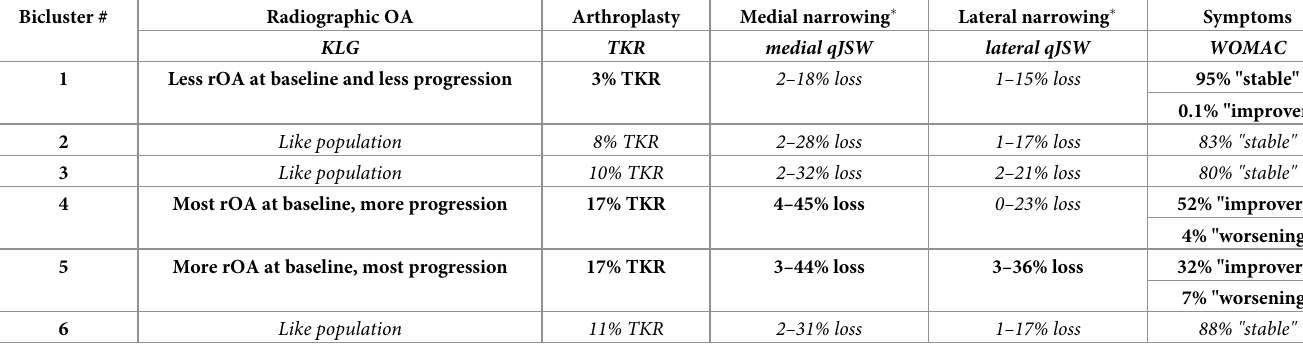
Table 4. Summary of outcomes by